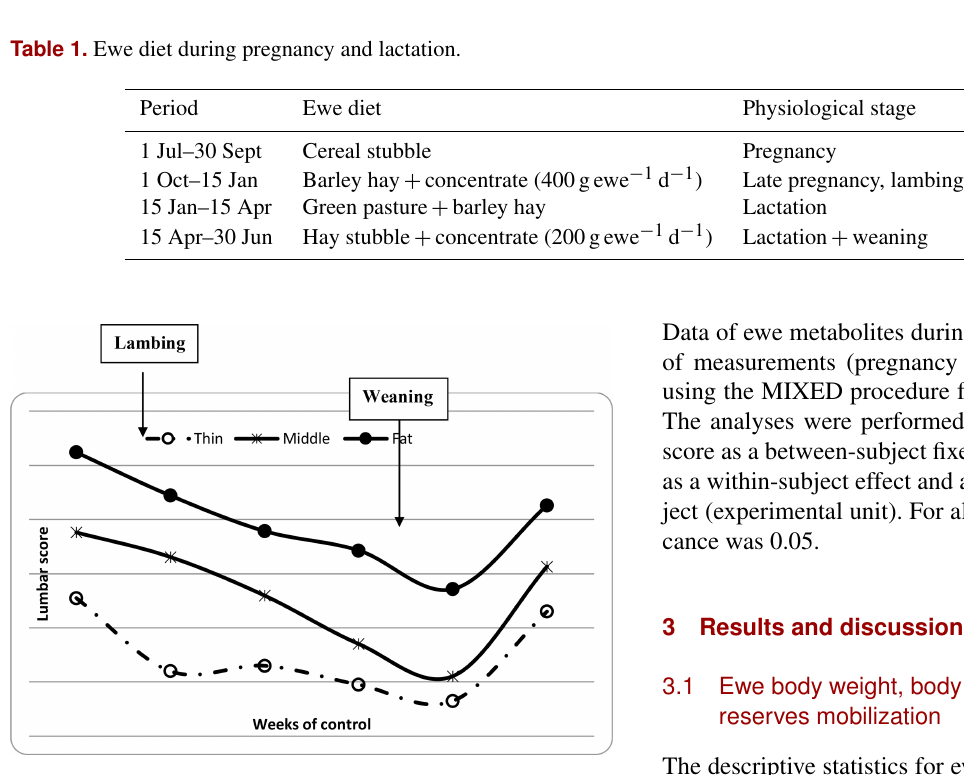
Figure 2. Variation of ewe lumbar scores from lambing to weaning period.